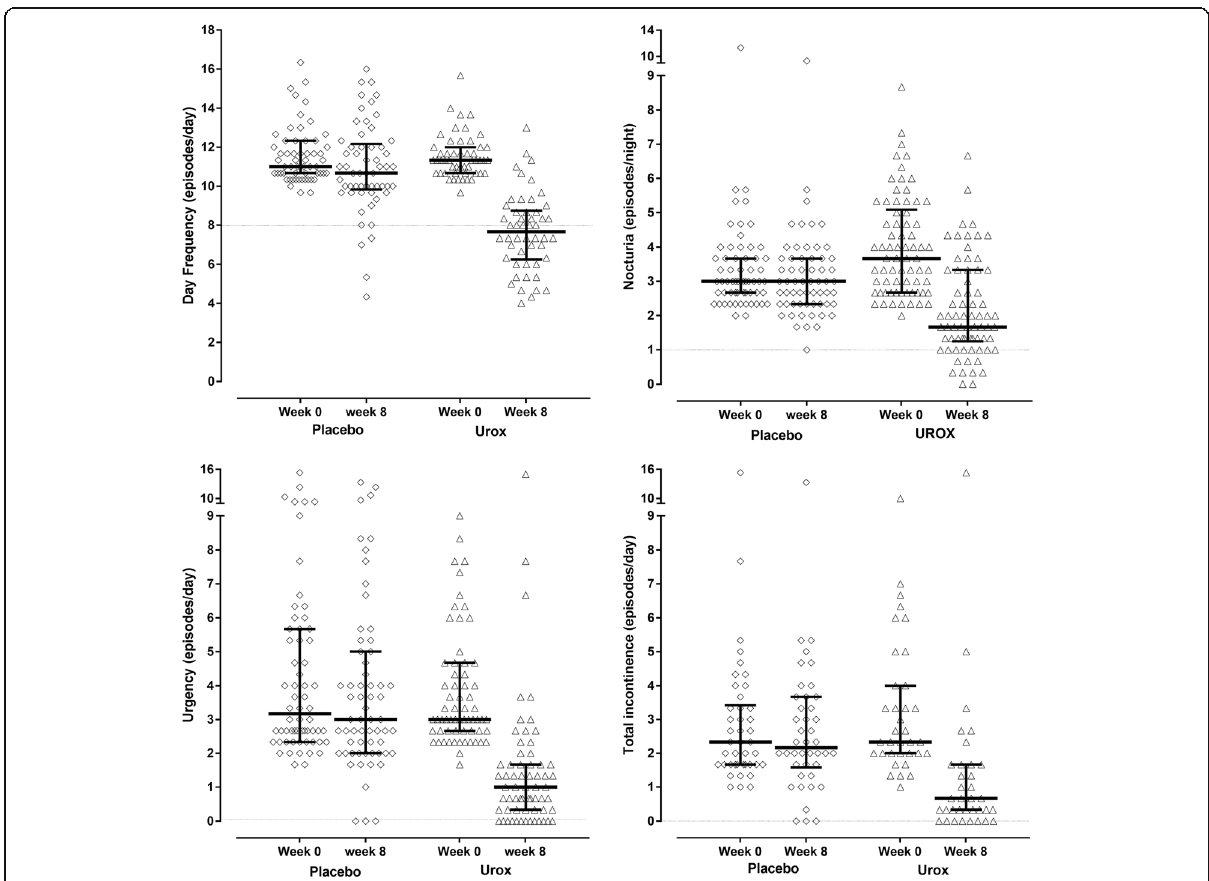
Fig. 2 Frequency of urinary symptoms averaged over three consecutive days (median, 25 and 75 percentile)